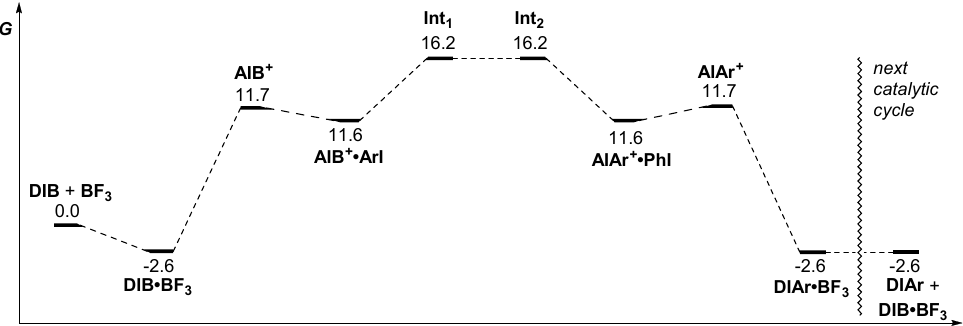
Scheme 6. Energy diagram of the proposed mechanism (energies reported in kcal/mol).